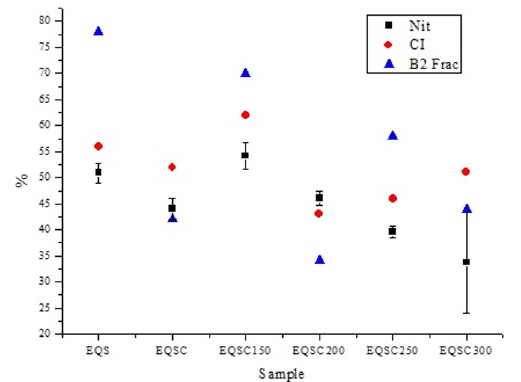
Figure 4. Confidence index (CI), B2 fraction and recovery energy (Nit) for the different kinds of samples studied in this work.